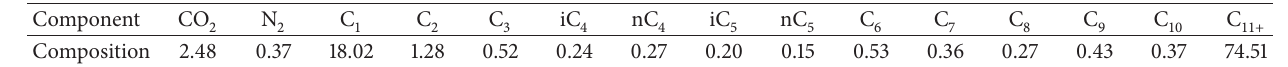
Table 4: The original composition of crude oil.